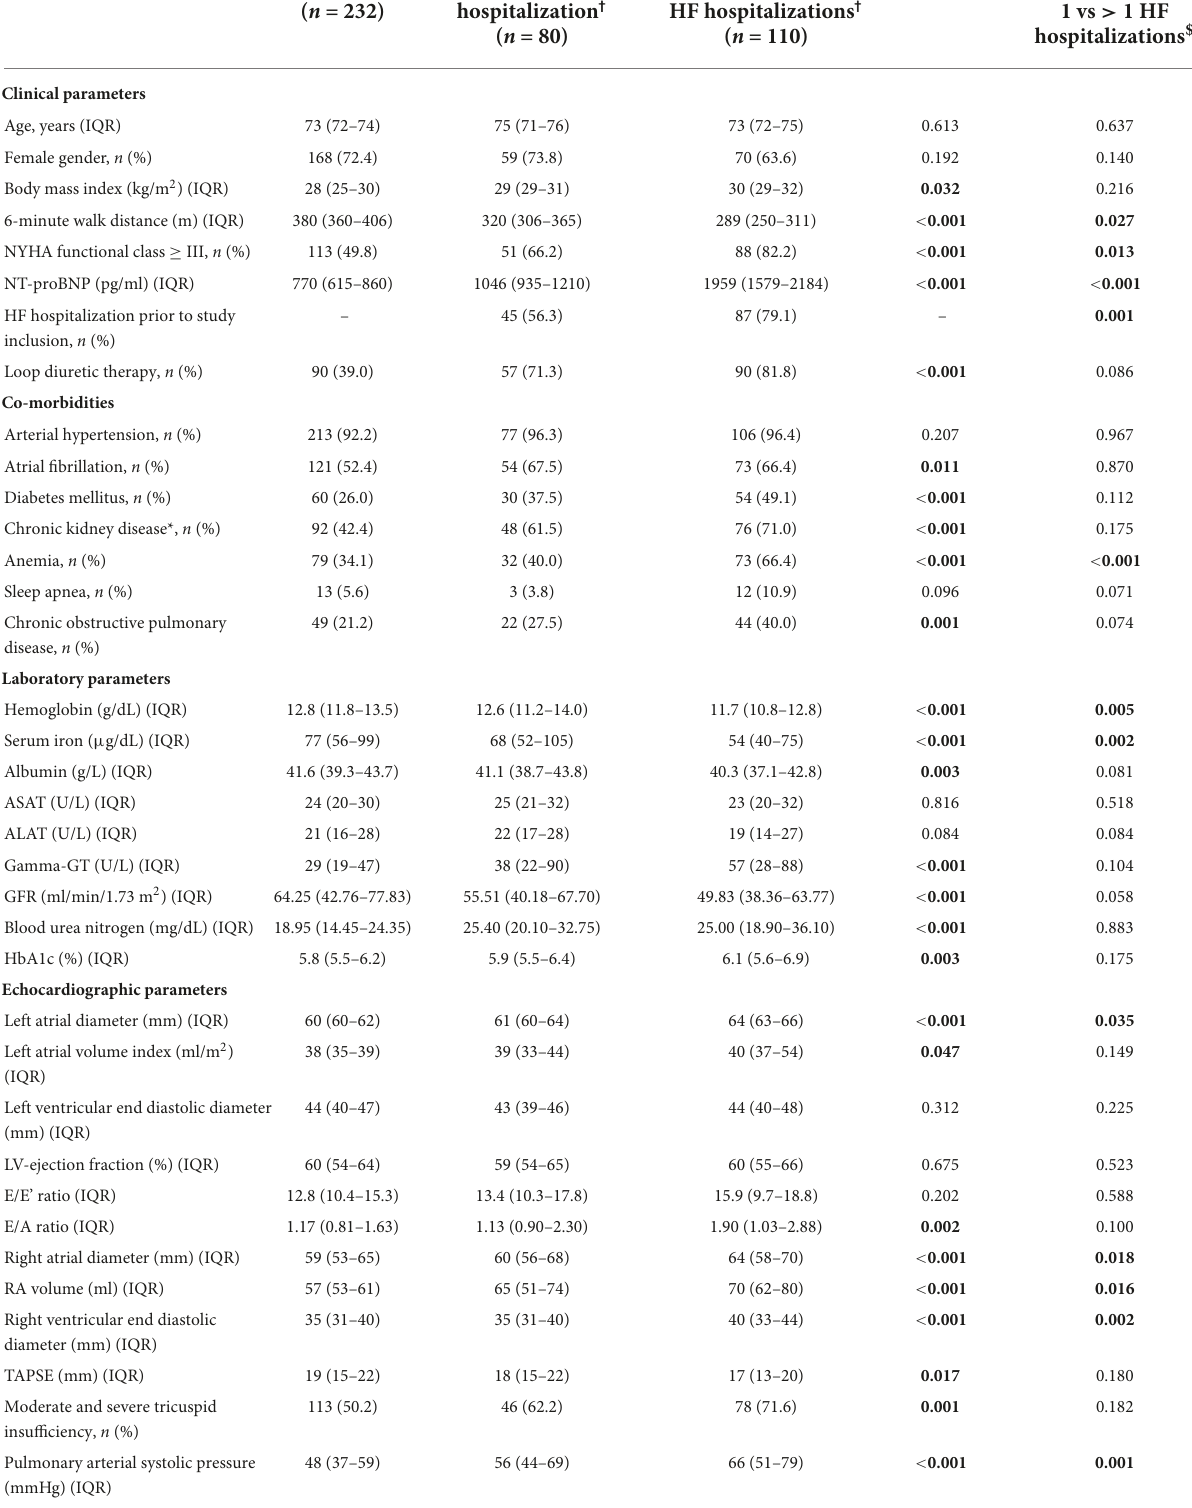
TABLE 1 Baseline characteristics of registered patients with one or recurrent episodes of acute heart failure requiring hospitalization. Stable patients Patients with one HF ( n = 232) hospitalization